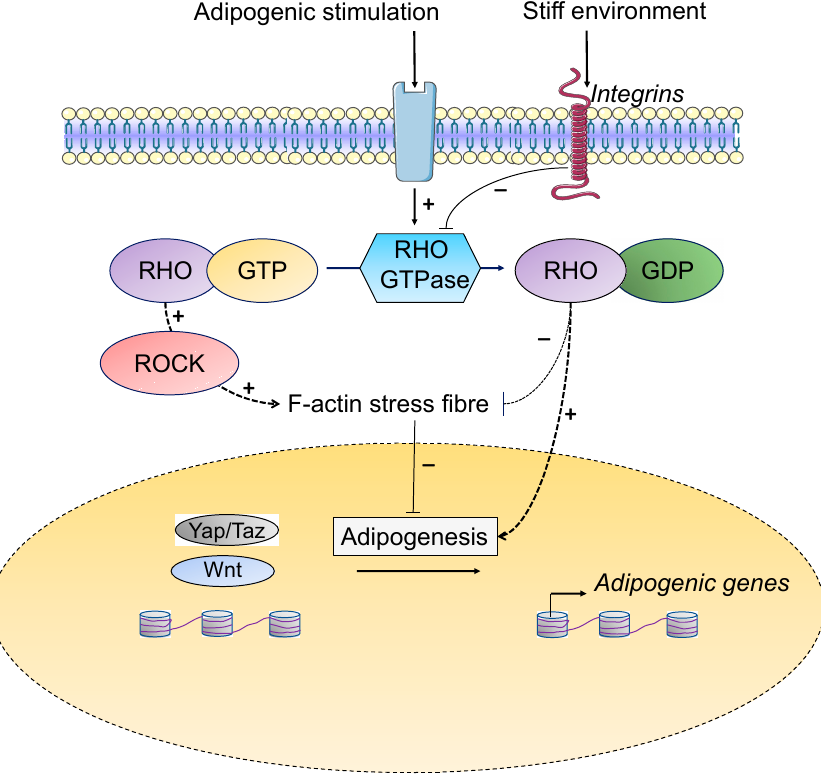
Figure 2. Microenvironment stiffness can regulate adipogenesis. During adipogenesis, the cells undergo substantial morphological modifications where spindle-shaped fibroblast-like preadipocytes become rounded mature adipocytes. There is an extensive reorganization of the cytoskeleton that allows lipid droplet growth and expansion. Upon adipogenic stimulation, the inhibition of Ras homolog family member A (RhoA) and Rho-associated protein kinases (ROCKs) disrupts actin cytoskeleton structures allowing adipogenesis. Thus, the inactive form, RHO GDP, promotes adipo- genesis. However, in stiff environments, focal adhesion assembly is promoted, RHO GTP activates ROCK, which, in turn, activates F-actin stress fiber formation and translocation of YAP/TAZ to the nucleus, which breaks